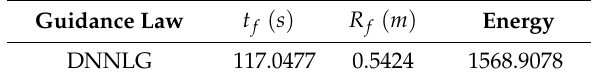
Table 3. Results of DNNLG law for 100 random initial conditions.